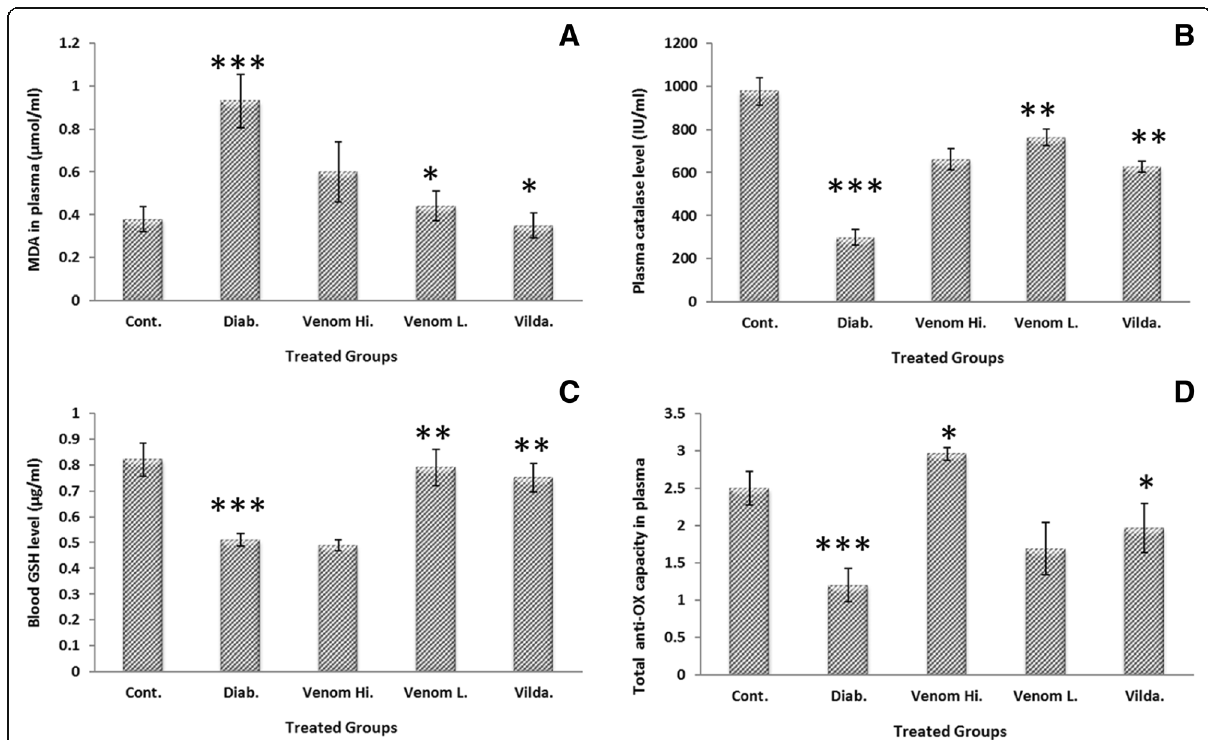
Fig. 2 Effect of BV and vildagliptin treatment on Plasma MDA level ( a ), catalase activity ( b ), GSH level ( c ), and total antioxidant capacity ( d ).One asterisk denotes significant differences in MDA levels between BV low dose and vildagliptin groups versus the diabetic group. Two asterisks denote significant differences in plasma catalase activity and blood GSH level between vildagliptin and BV low and BV high doses compared to the diabetic group.Three asterisks denote significant differences in MDA, GSH levels, and CAT activity between diabetic and control groups, using